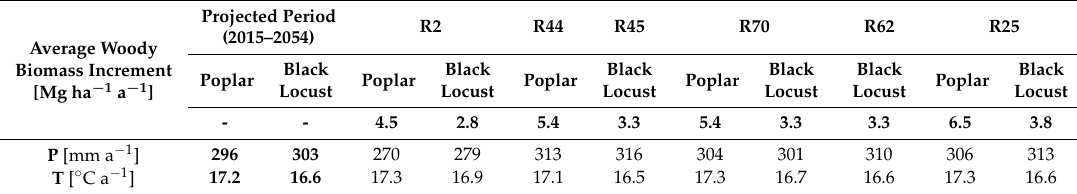
Table 4. Realisations that rendered minimum, mean, and maximum average woody biomass increment values for both tree species under a timeframe of forty years, together with their climatic characteristics in terms of average annual values for precipitation sum and air